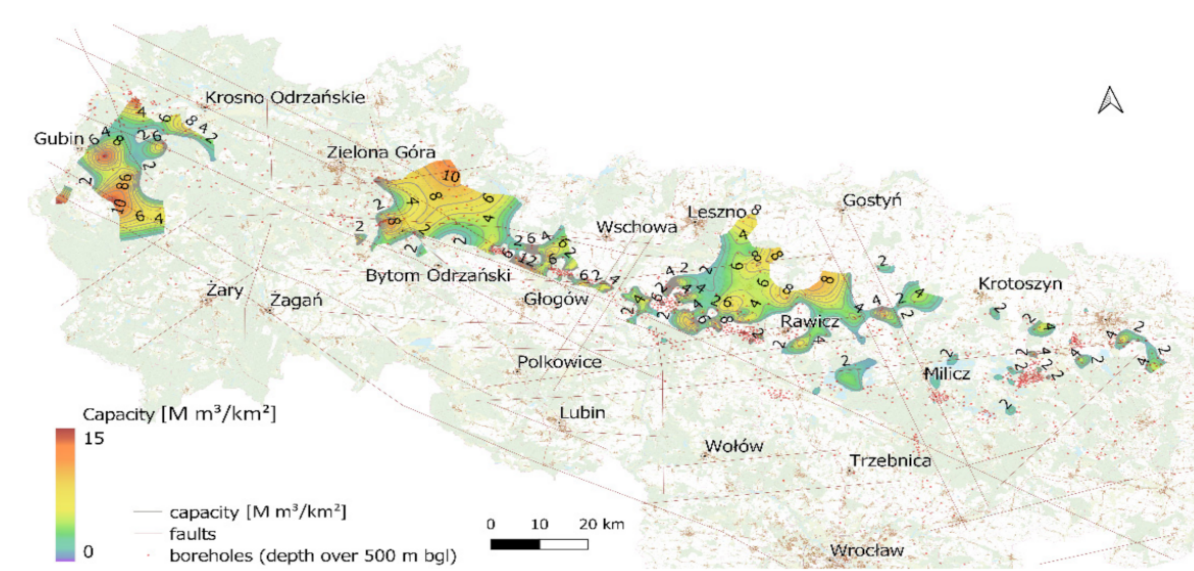
Figure 9. The storage capacity of liquid fuels in the rock salt layer in the Fore-Sudetic Monocline, operational caverns (target cavern volume).